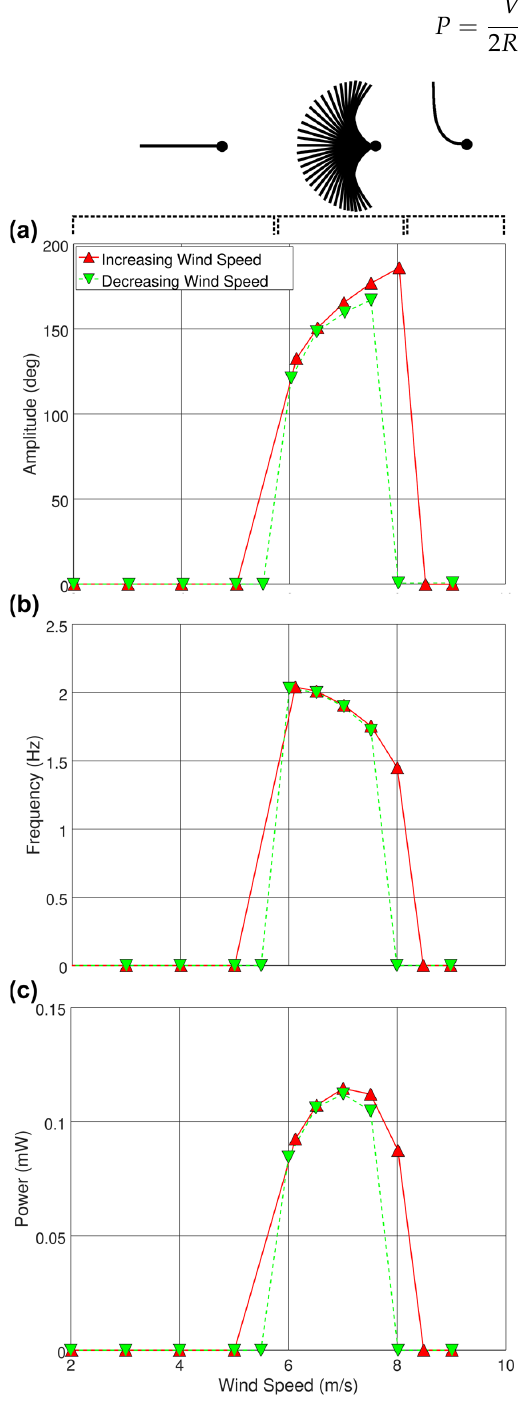
Figure 4. Preliminary characterization of the inverted flag response: ( a ) amplitude of motion, ( b ) flapping frequency, and ( c ) power output versus wind speed, for both increasing and decreasing wind speed. Schematic representations of the observed dynamic responses of this inverted flag (static aligned, large-amplitude flapping oscillation, and deflected) are shown as insets at the top of the